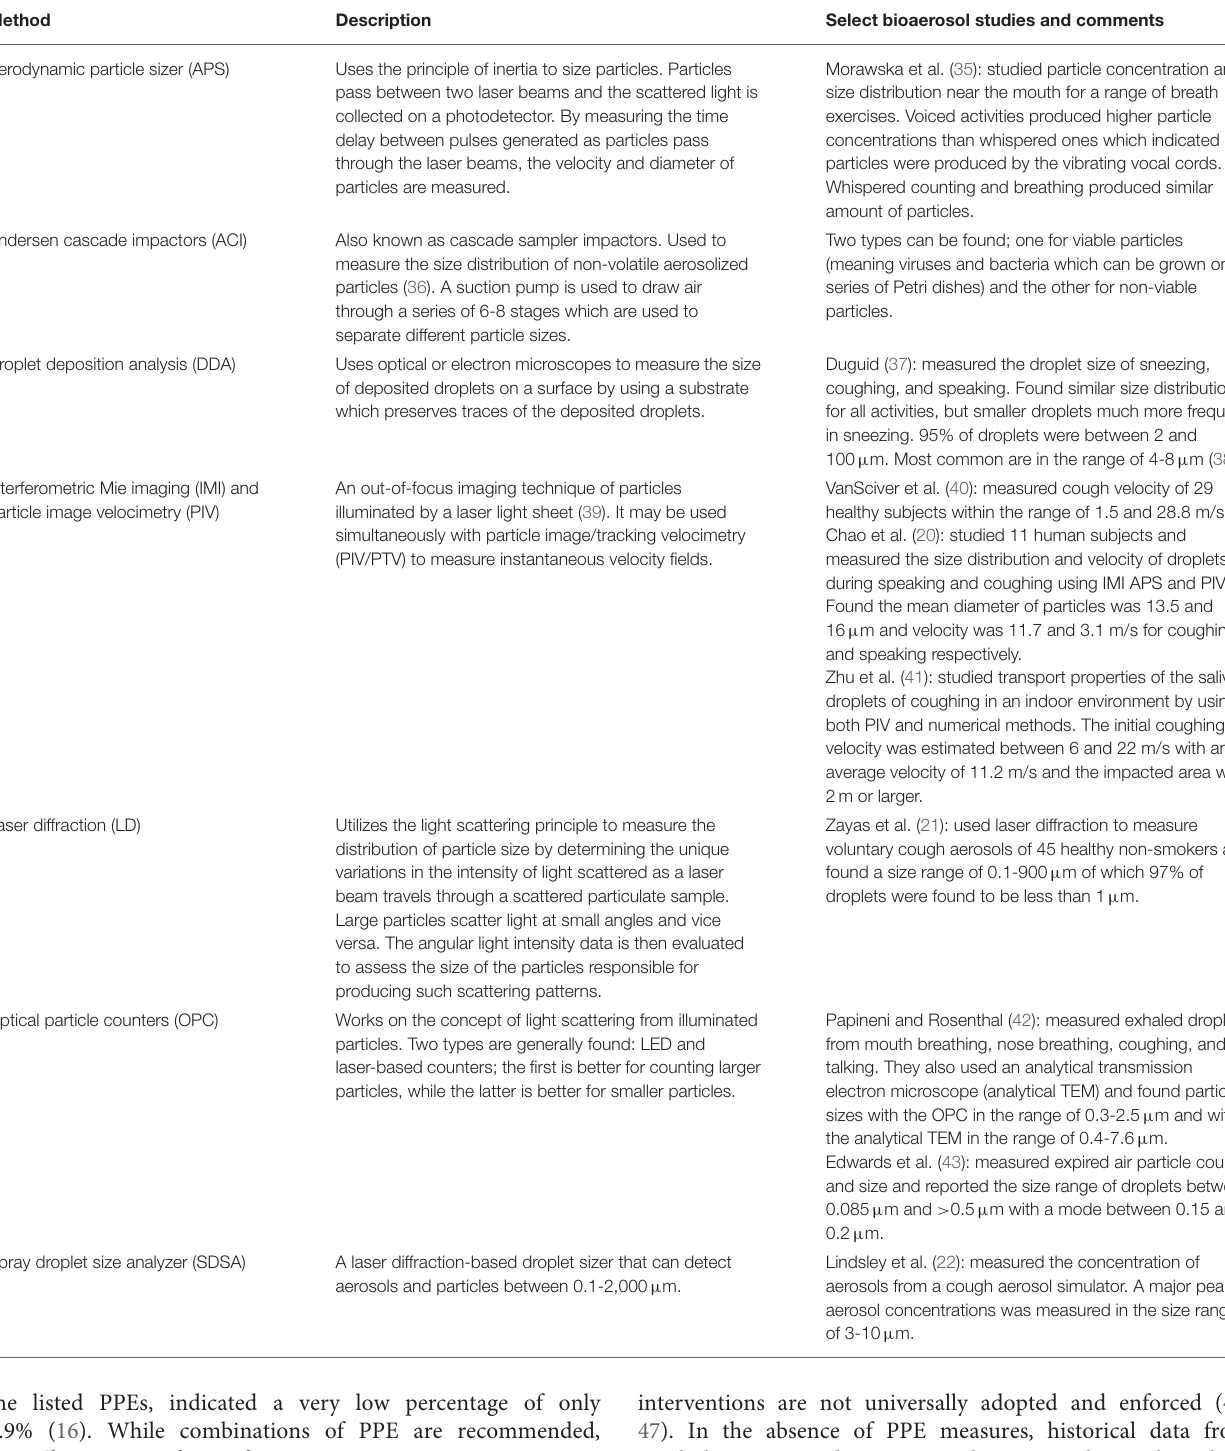
TABLE 1 | Experimental methods used for particle count and